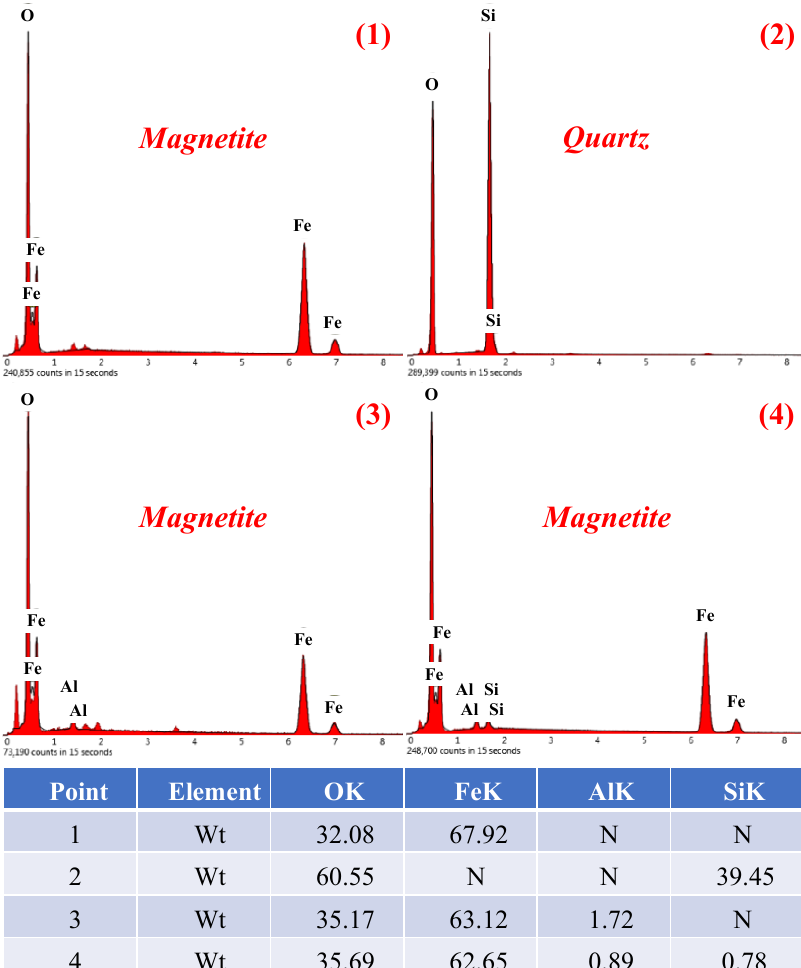
Figure 13. SEM-EDS results of the iron ore concentrate.